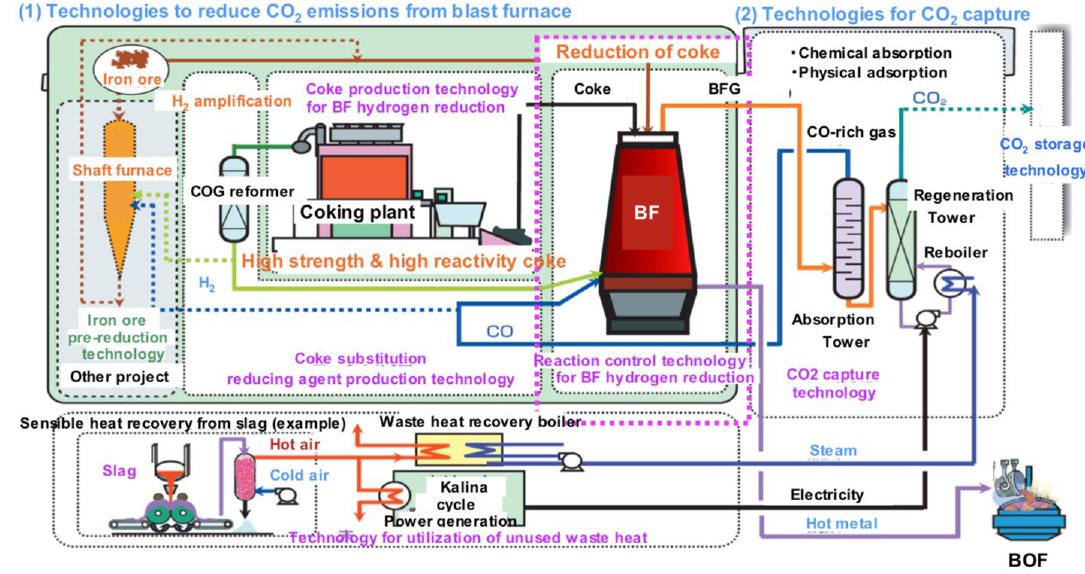
Figure 26. The Japanese COURSE50 program (source: ISIJ).